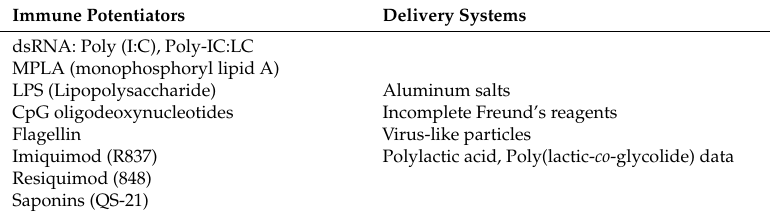
Table 2. Few types of adjuvants used and their